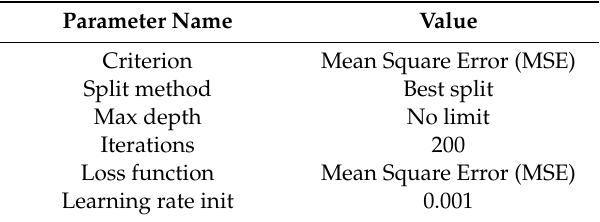
Table 9. Parameters setting of DTR